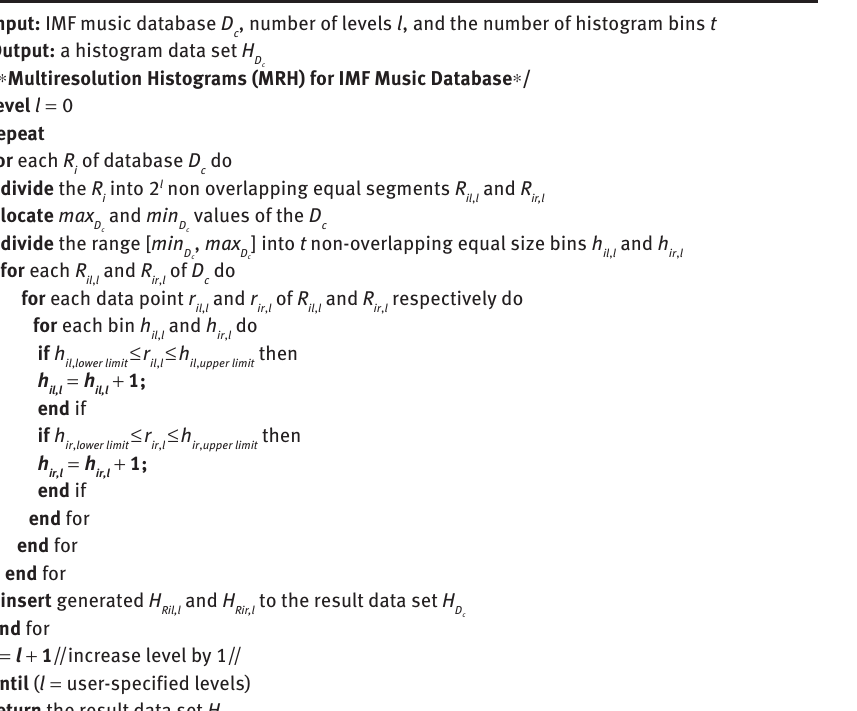
Algorithm 2: Procedure to construct MRH for IMF music